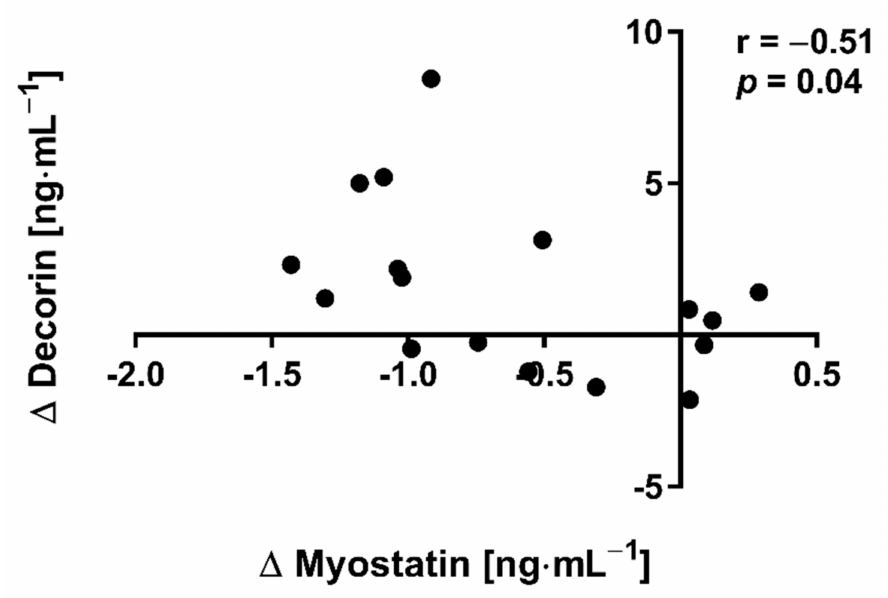
Figure 3. Correlation of myostatin and decorin concentration delta changes ( ∆ POST to PRE) in response to NW training.